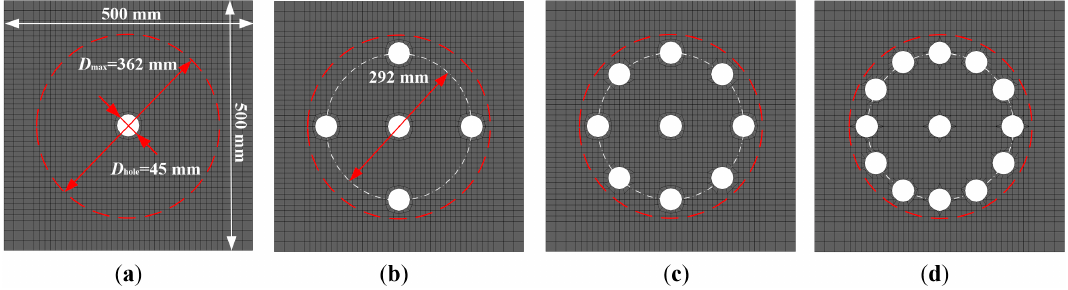
Figure 2. Design of rock models with different numbers of holes: ( a ) one hole; ( b ) five holes; ( c ) nine holes; and ( d ) 13 holes.